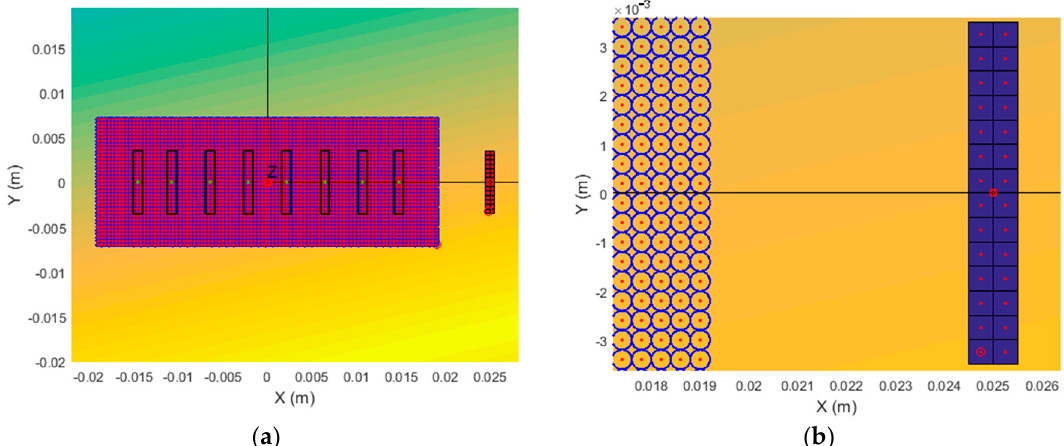
Figure 4. Image of excitation area and first receiving virtual element: ( a ) general view and ( b ) zoomed image of receiving zone in vicinity of receiving element 1.